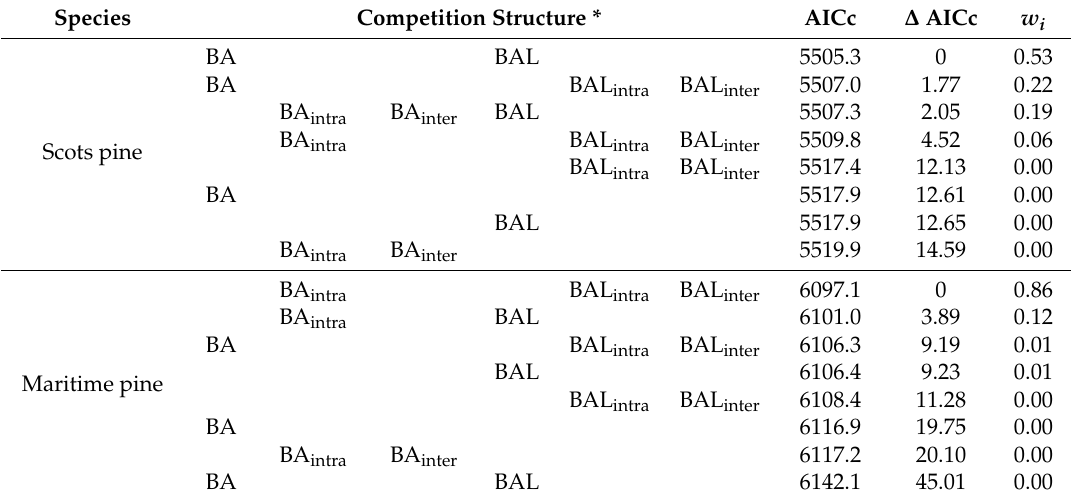
Table 4. Ranking of basal area increment models comparing alternative measures of competition. Competitive status was compared for the size-symmetric (BA) and size-asymmetric competitors (BAL) separated into intraspecific and interspecific components. Models ranked according to their ∆ AICc: difference of AICc values between the best model and the i th model; and w i : Akaike